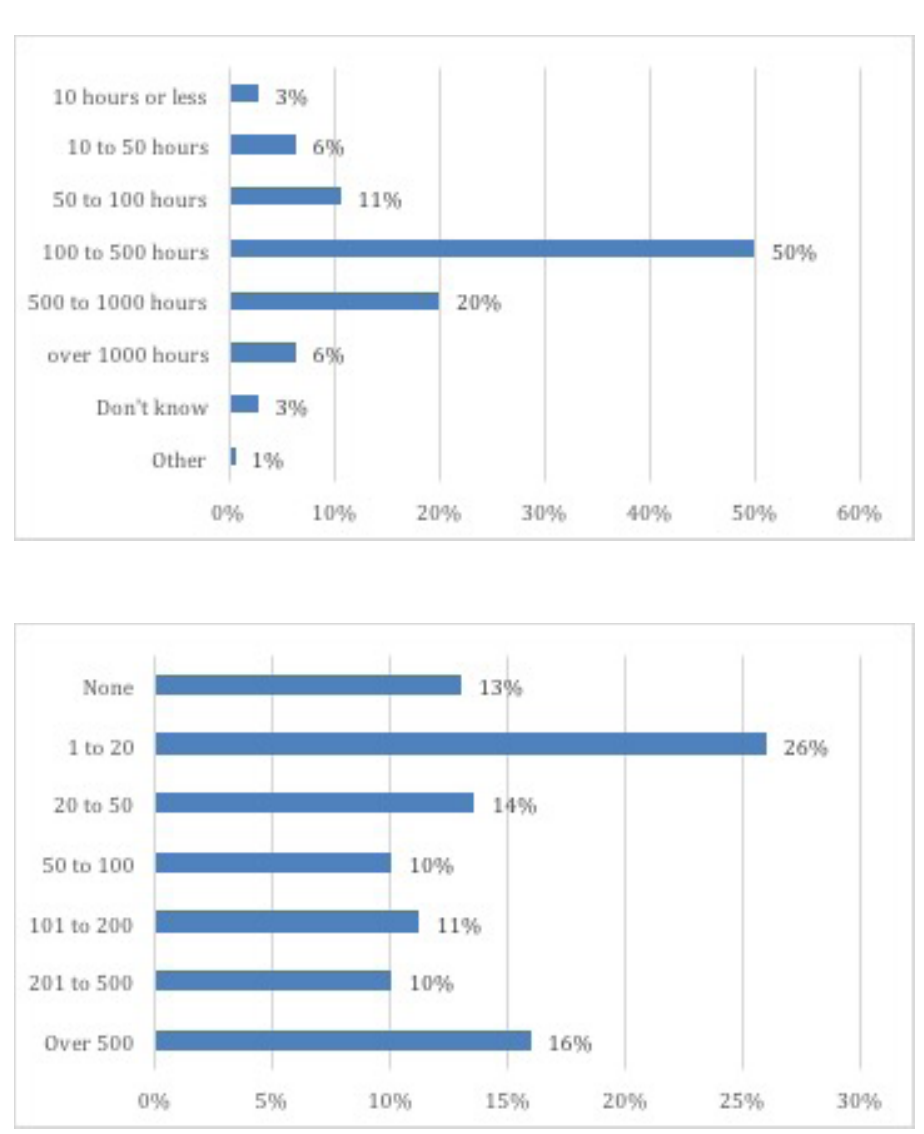
Figure 5: Results of the ‘2015 Danish detectorists survey’. Detectorists were asked how many hours they spend metal detec- ting on an annual basis (top) and how many finds they had handed over to a local museum in total (bottom).